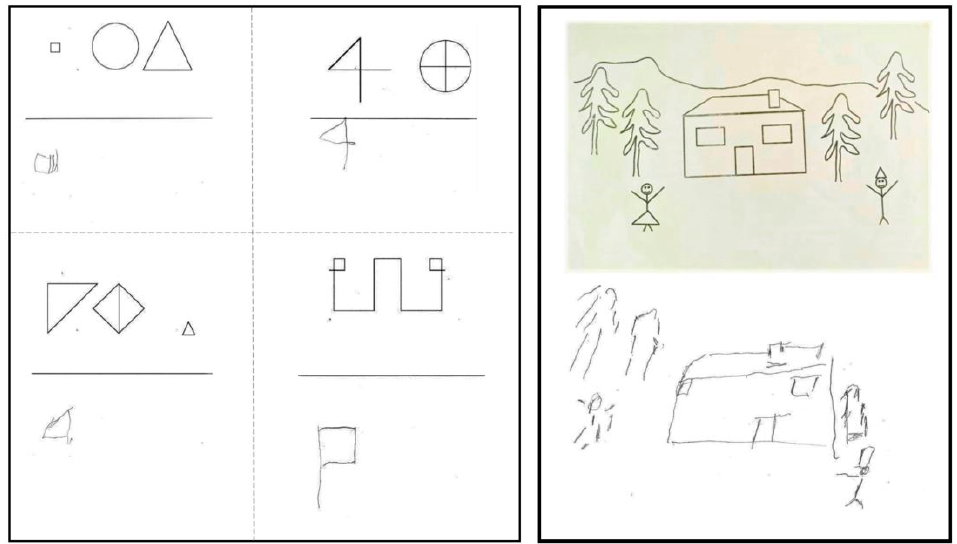
Figure 2. Samples of the copy of figures performed by the patients: Left panel shows the copy of simple figures performed by P1. She drew only the figure on the extreme left of her space. Right panel shows the copy of a figure drawn by P2. He did not draw the tree on the extreme part of the right space, the right arm of the person-figure in his right space, and a little part of the roof at its extreme right side.